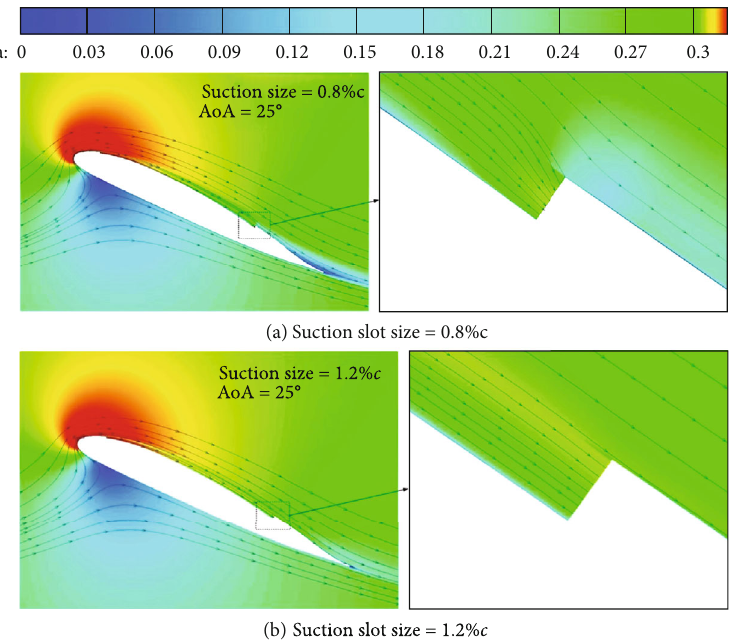
Suction slot size =